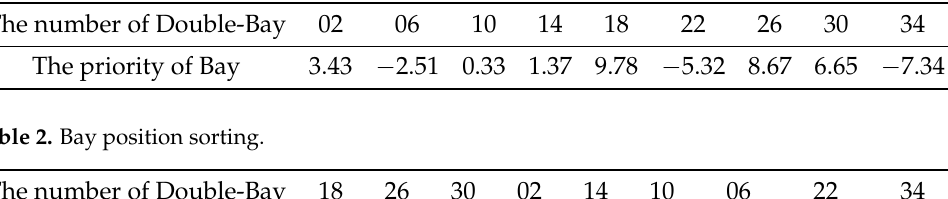
Table 1. Bay priority assignment. The number of Double-Bay